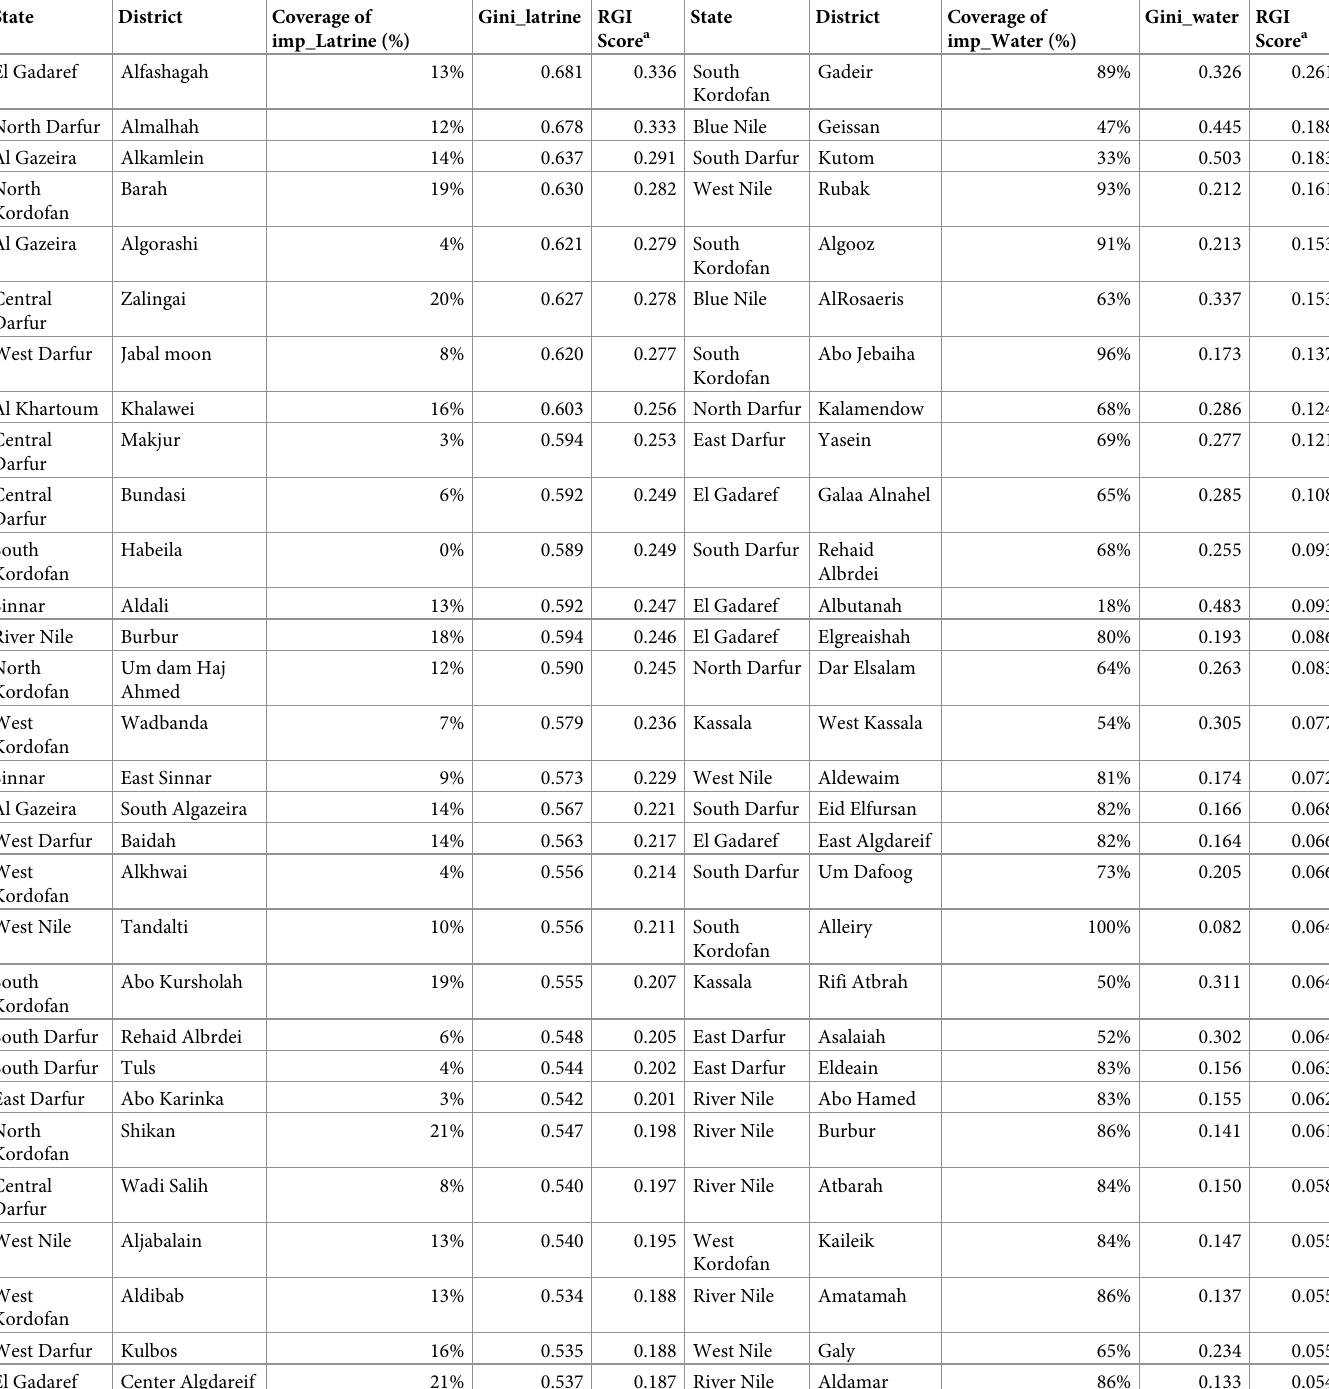
Table 5. Key districts with high RGI scores that had higher GINI values observed than expected.